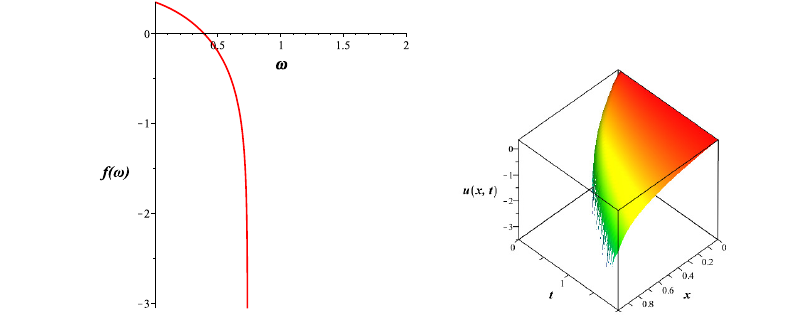
Figure 14. The shape function for the Lorentz noise for a = 1 / 2 ,λ = 2, ν = 1 / 2 and for c 1 = c 2 = 1 .